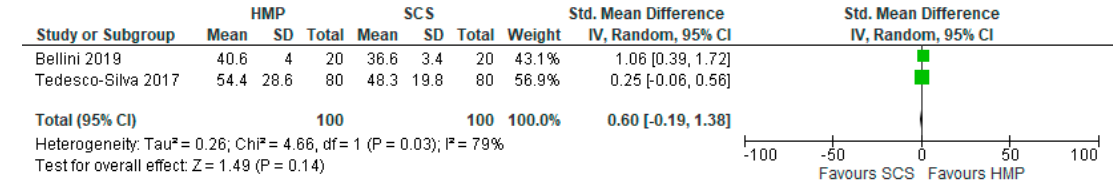
Figure 10. Estimated glomerular filtration rate (eGFR) in kidneys preserved via HMP and SCS; eGFR day 365.